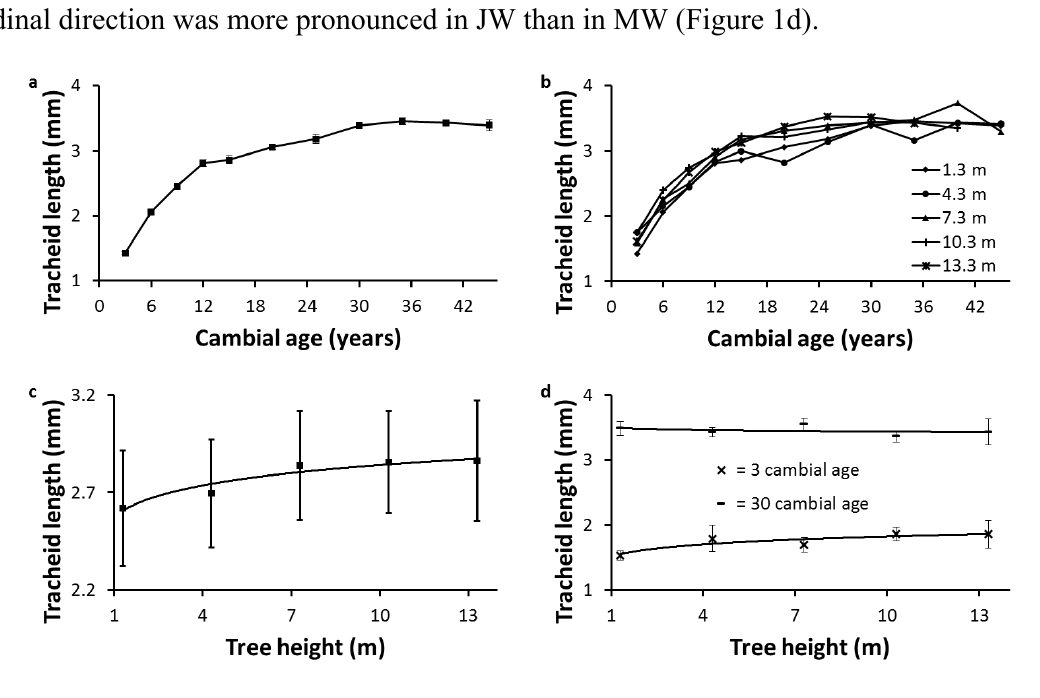
Figure 1. Radial and longitudinal variations in tracheid length (TL): ( a ) radial variation in tracheid length at breast height (1.3 m); ( b ) radial variation in tracheid length from 1.3 to 13.3 m; ( c ) longitudinal variation in average (cambial age 3–30) tracheid length; and ( d ) longitudinal variation in juvenile (cambial age 3) and mature (cambial age 30) tracheid length. Bars indicate standard